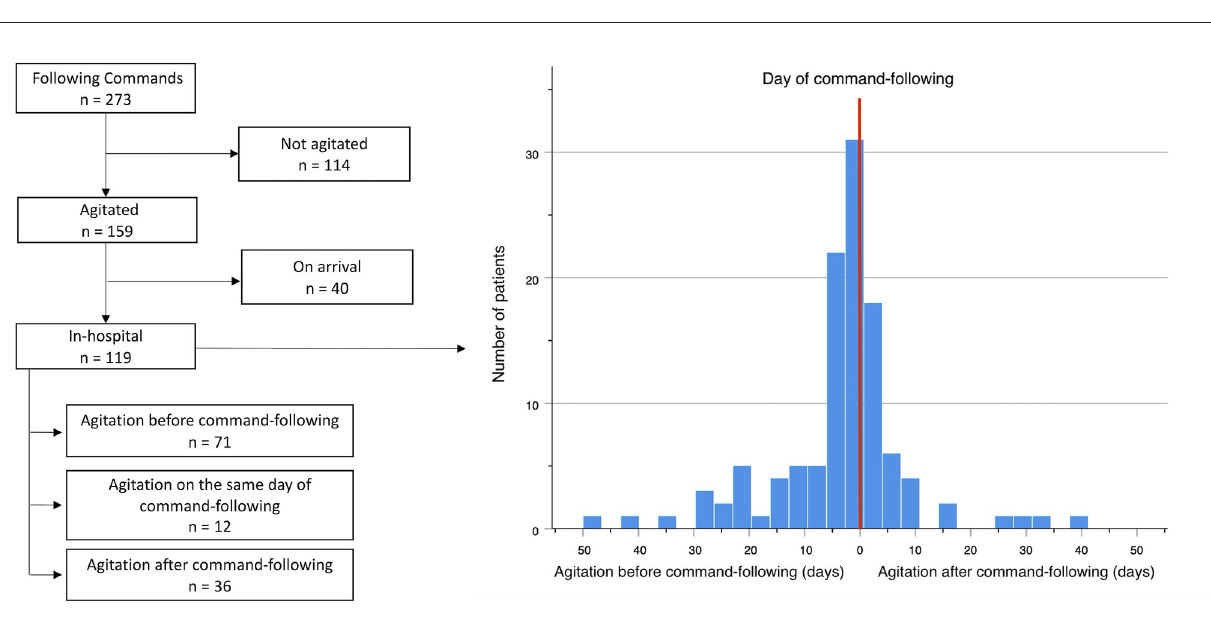
FIGURE 3 | Temporal association between onset of agitation and command-following, n = 119. Red line represents the day the patient begins following commands. X-axis shows numbers of days from agitation onset to command-following. Left to the red line represents days from agitation to command-following. Right to the red line represents days from command following to agitation. Y-axis corresponds to the number of